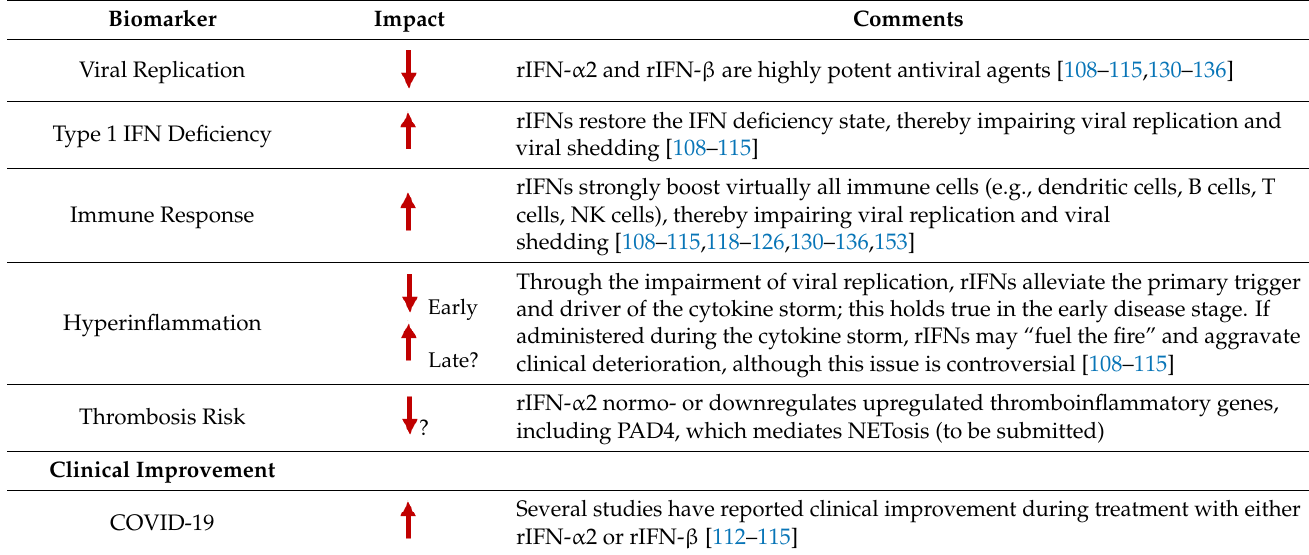
Table 1. Some key questions with regard to the impact of rIFN- α2 and rIFN - β on clinical, biochem- ical, and immunological markers in MPNs. Table 2. Rationales for treatment with rIFN- α 2 and rIFN- β in patients with MPNs and COVID-19.